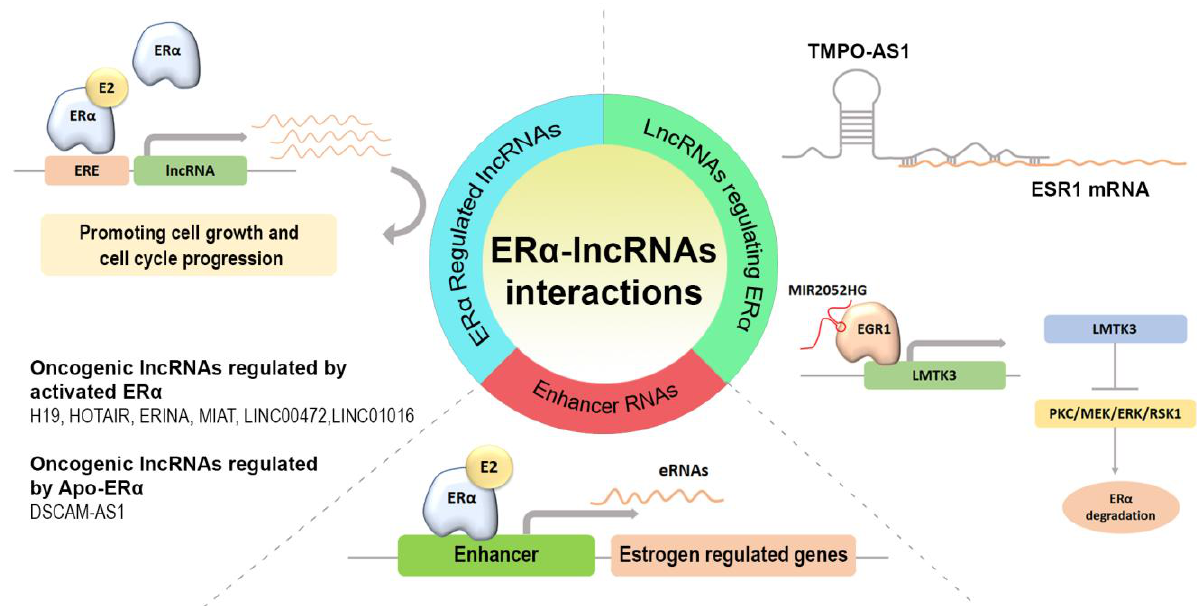
Figure 1. Schematic representation of the ERα -lncRNAs interactions reviewed in the text.